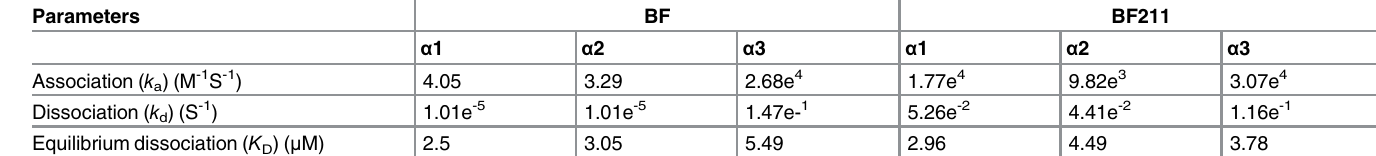
Table 2. Parameters of binding between BF or BF211 with α 1, α 2 or α 3 recombinant subunit protein of Na+/K+-ATPase.